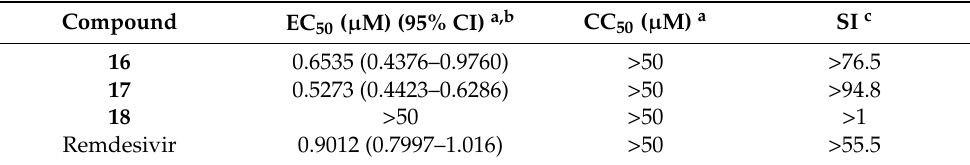
Table 1. Anti-SARS-CoV-2 activity and cytotoxicity of the tested compounds in Vero cells. Compound